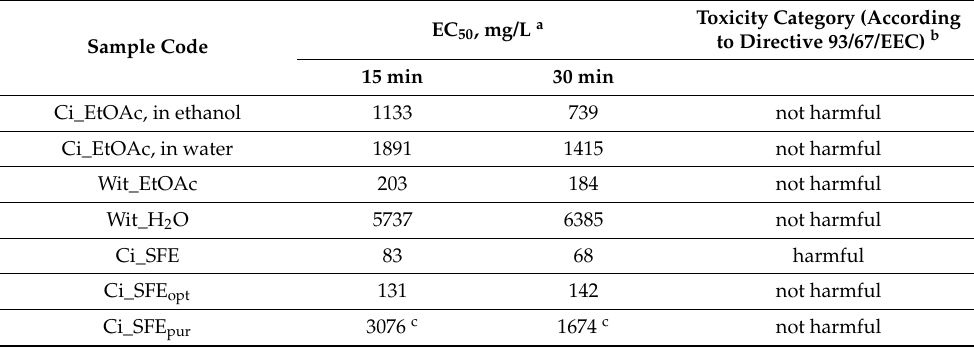
Table 7. Cytotoxicity assessment with Aliivibrio fischeri .